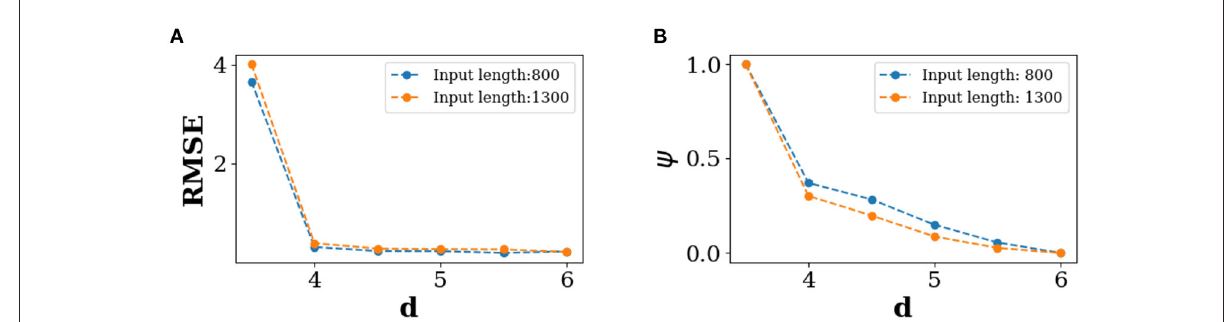
FIGURE5 Predictability of extreme events. For 20 extreme events, (A) RSME against threshold d for different length of input data, (B) average phase against threshold d for different length of input data. Here, for both cases the average of 400 realizations are presented. Instantaneous phase φ i ( t ) of ith signal is estimated using the Hilbert transform